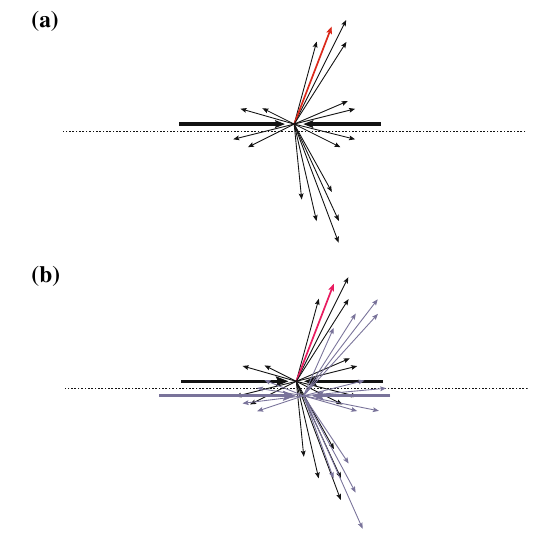
Fig. 2 a Single collision on the y − z plane with partons produced due to hard process and initial and final state radiation. The thick lines rep- resent the incoming partons while the red arrow represents the selected trigger parton. The total transverse momentum of all partons sums up to zero. b An event with two hard collisions. For each hard collision the momentum is conserved independently, if no correlations are present